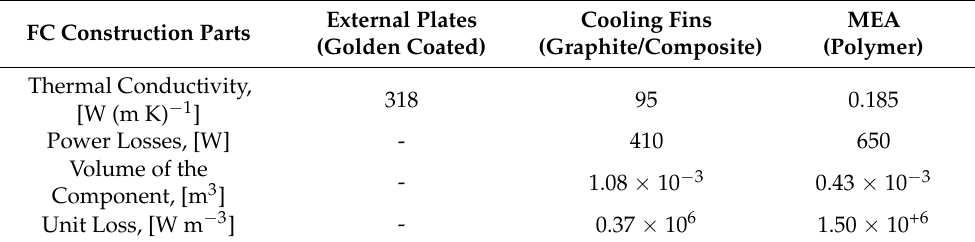
Table 2. Material properties and power loss values used for CFD modeling